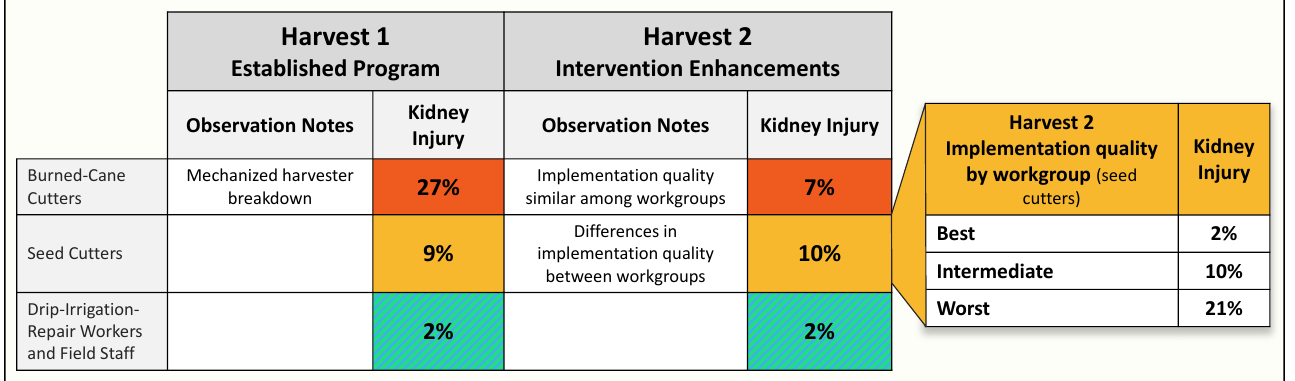
Figure 3. Incidence of hospitalized acute kidney injury (AKI) across three harvests. Percentages based on all sugarcane workers active in each job type